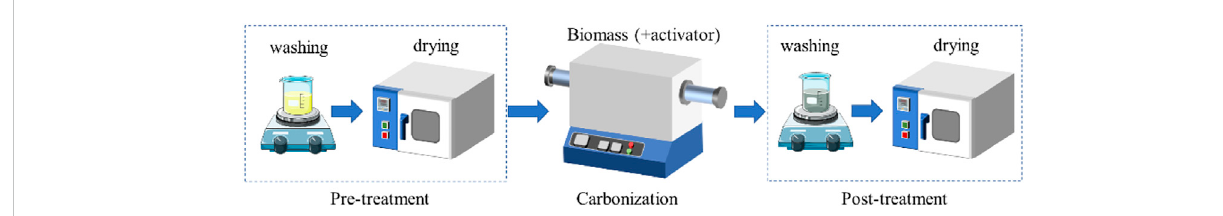
One-step method commonly used for N self-doped biochar production.